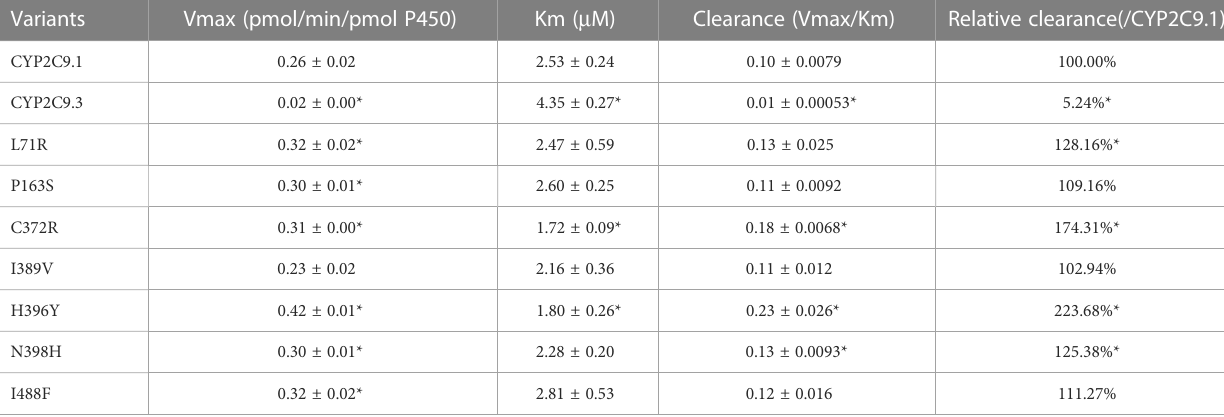
TABLE 5 Enzyme kinetic values of recombinant wild type and CYP2C9 variants towards losartan.